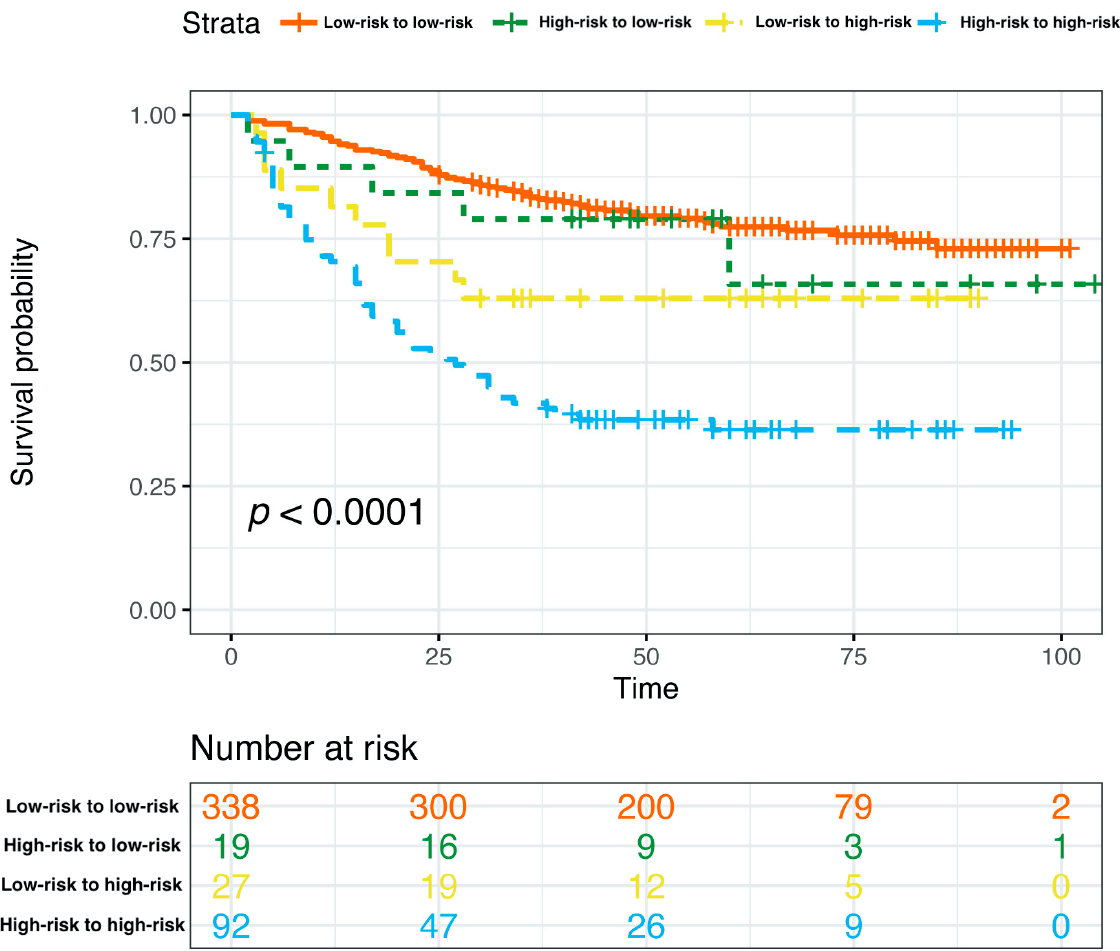
Figure 10. Kaplan–Meier estimates of DFS according to risk category shifts in the primary cohort. Abbreviations: DFS, disease ‐ free survival; pCR, pathologic complete response. Abbreviations: DFS, disease-free survival; pCR, pathologic complete